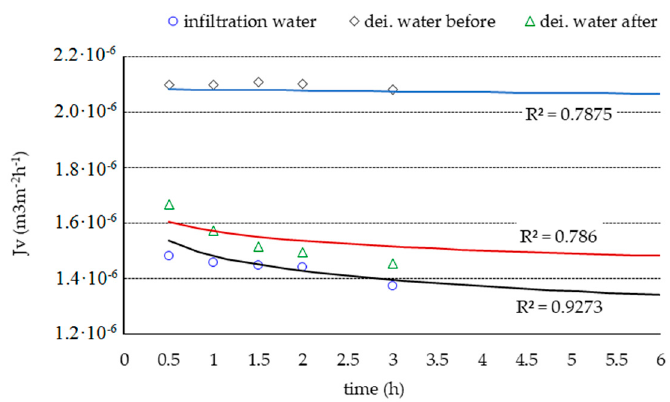
Figure 1. Dependence of the volumetric stream of deionized water and infiltration water on time, where: dei. water—deionized water.